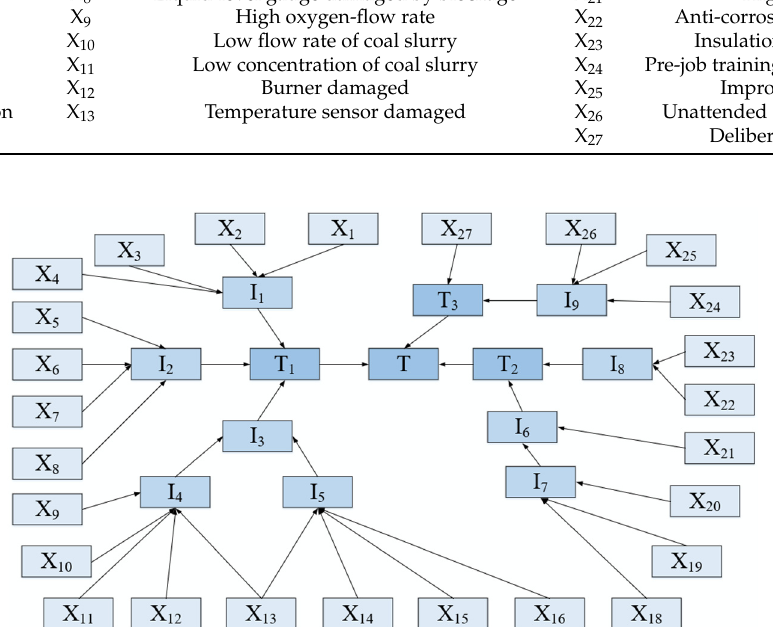
Figure 8. The Bayesian network for the failure of the gasifier mapped from FT.